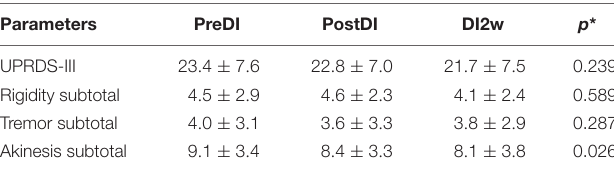
TABLE 2 | Scores of the UPDRS indicators across the program of DI and after it in the DI group.